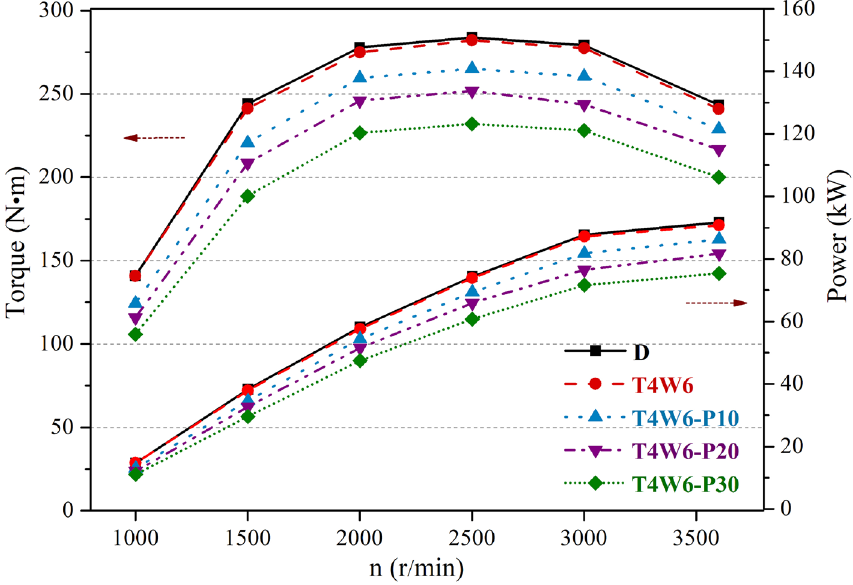
Figure 5. Effect of the polyoxymethylene dimethyl ethers (PODEn) blending ratio on the power performance of the diesel engine.